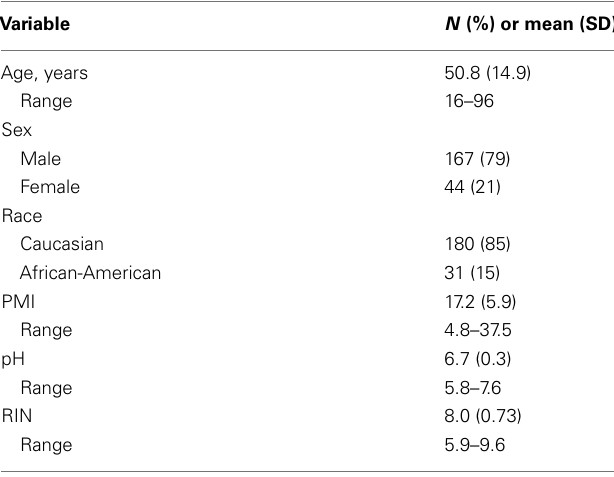
Table 2 |Technical variables for human postmortem brains used in QTL and gene network